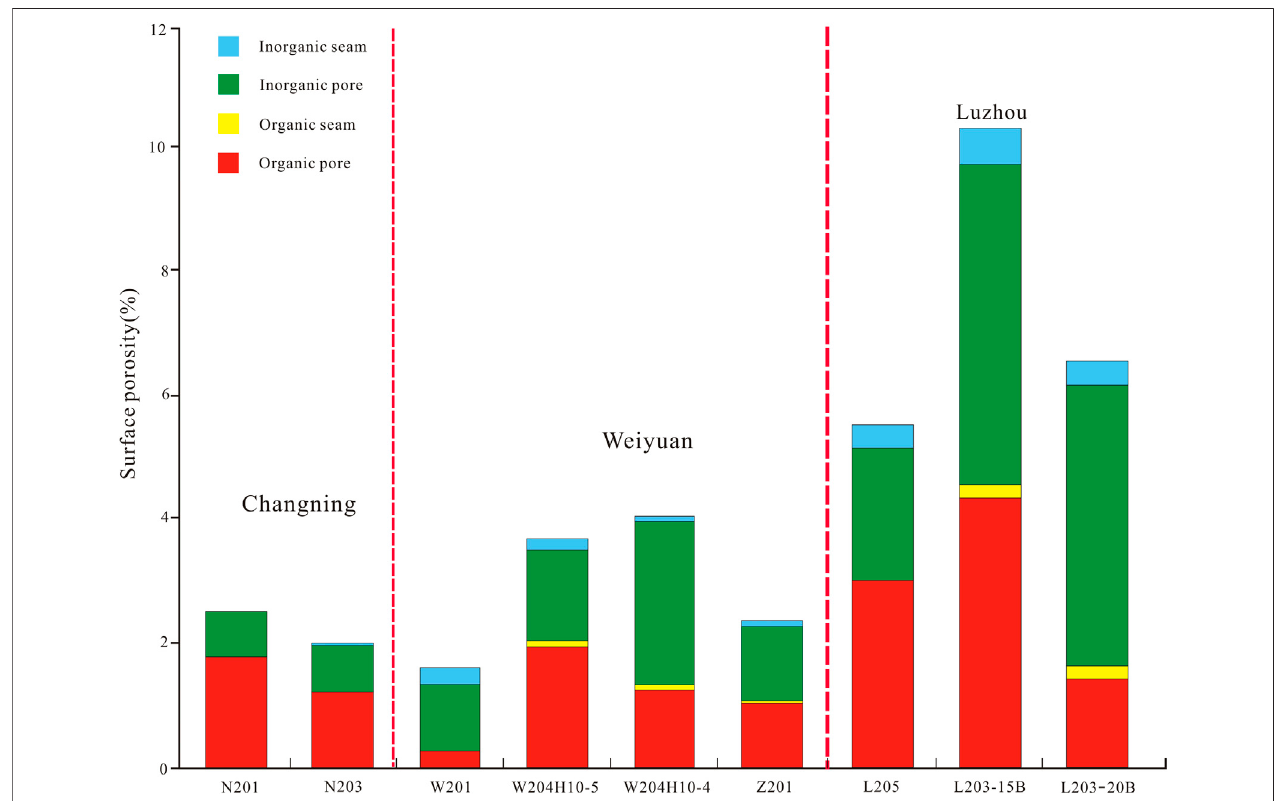
FIGURE 9 | Composition of shale pore space in the Wufeng Longmaxi Formation in the Changning, Weiyuan and Luzhou areas in southern Sichuan.